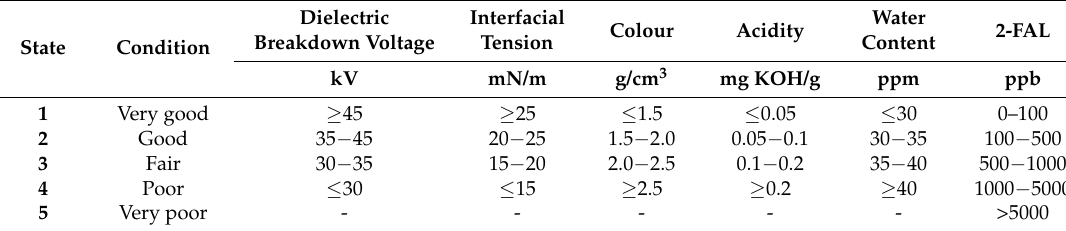
Table 2. Recommended condition parameter limit and condition for oil quality.